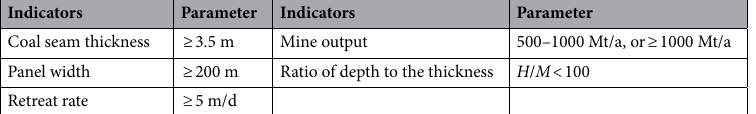
Table 2. Positive external indicators of large-scale underground longwall